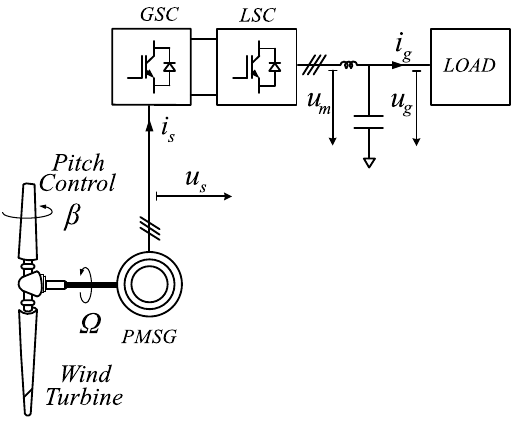
Figure 1. Complete system scheme. PMSG: permanent magnet synchronous generator; LSC: line side converter; GSC: generator side